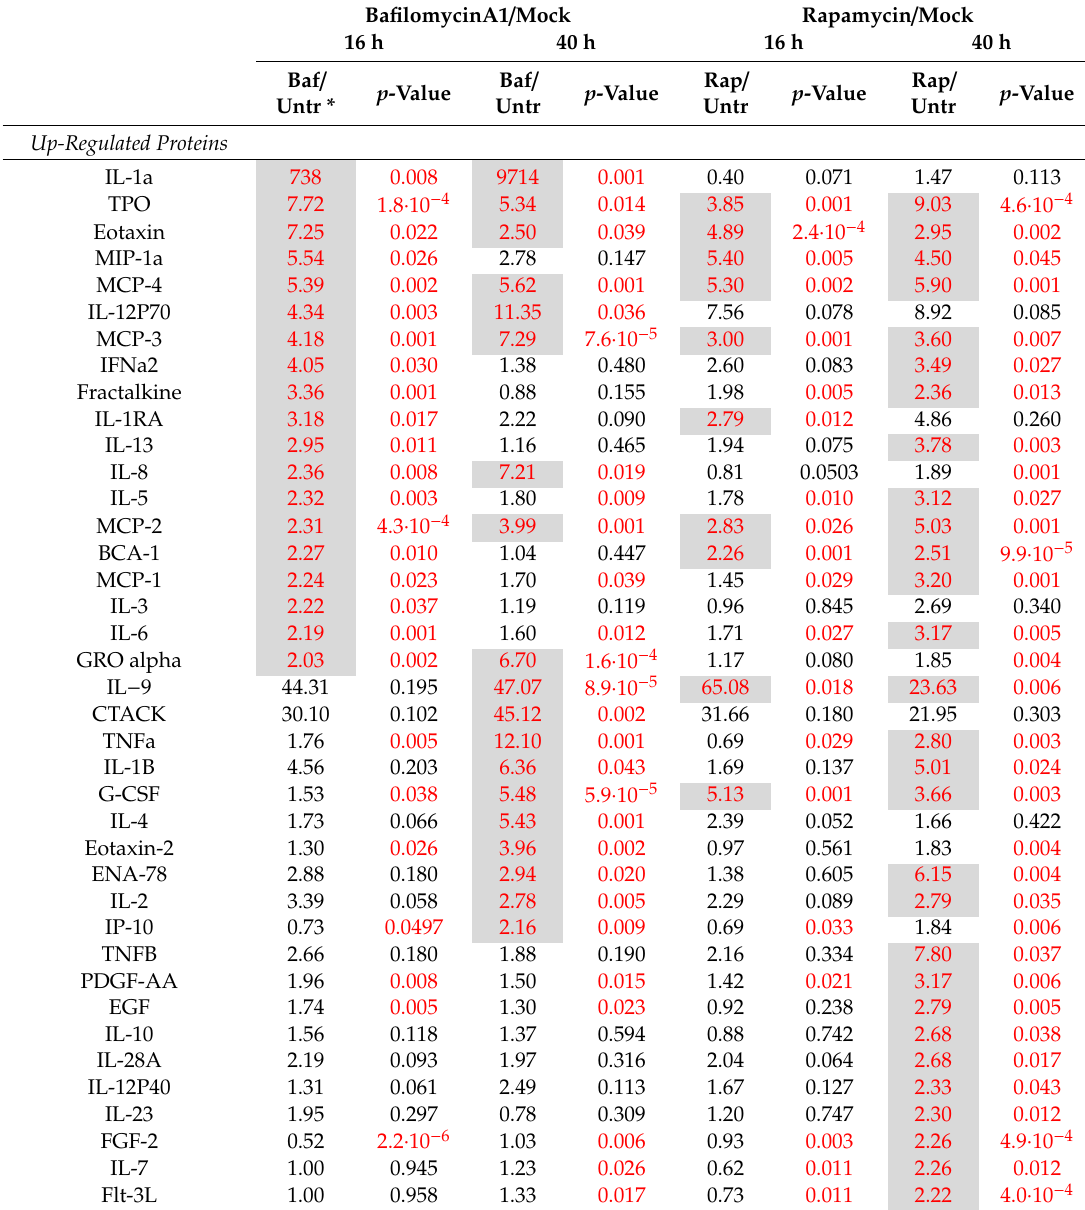
Table 3. Secreted U-251 cytokines dysregulated by BafilomycinA1 or